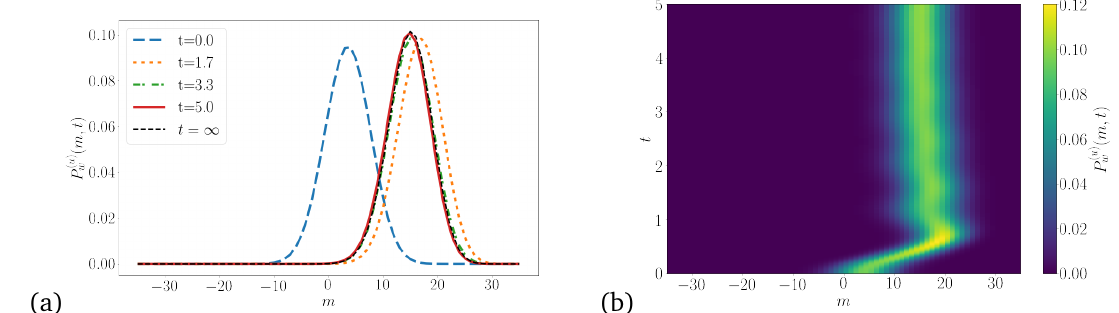
( m , t ) at times t = 0,1.7,3.3,5.0 after a w